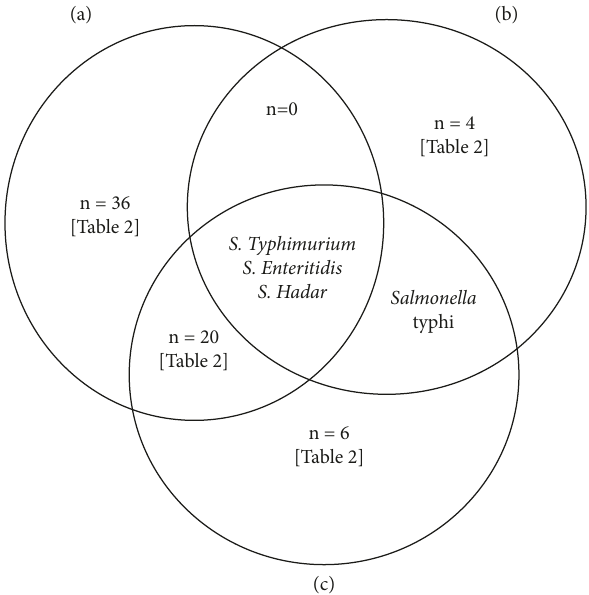
Figure 5: Venn diagram showing the shared isolates between (a) animals, (b) humans, and (c) the environment.